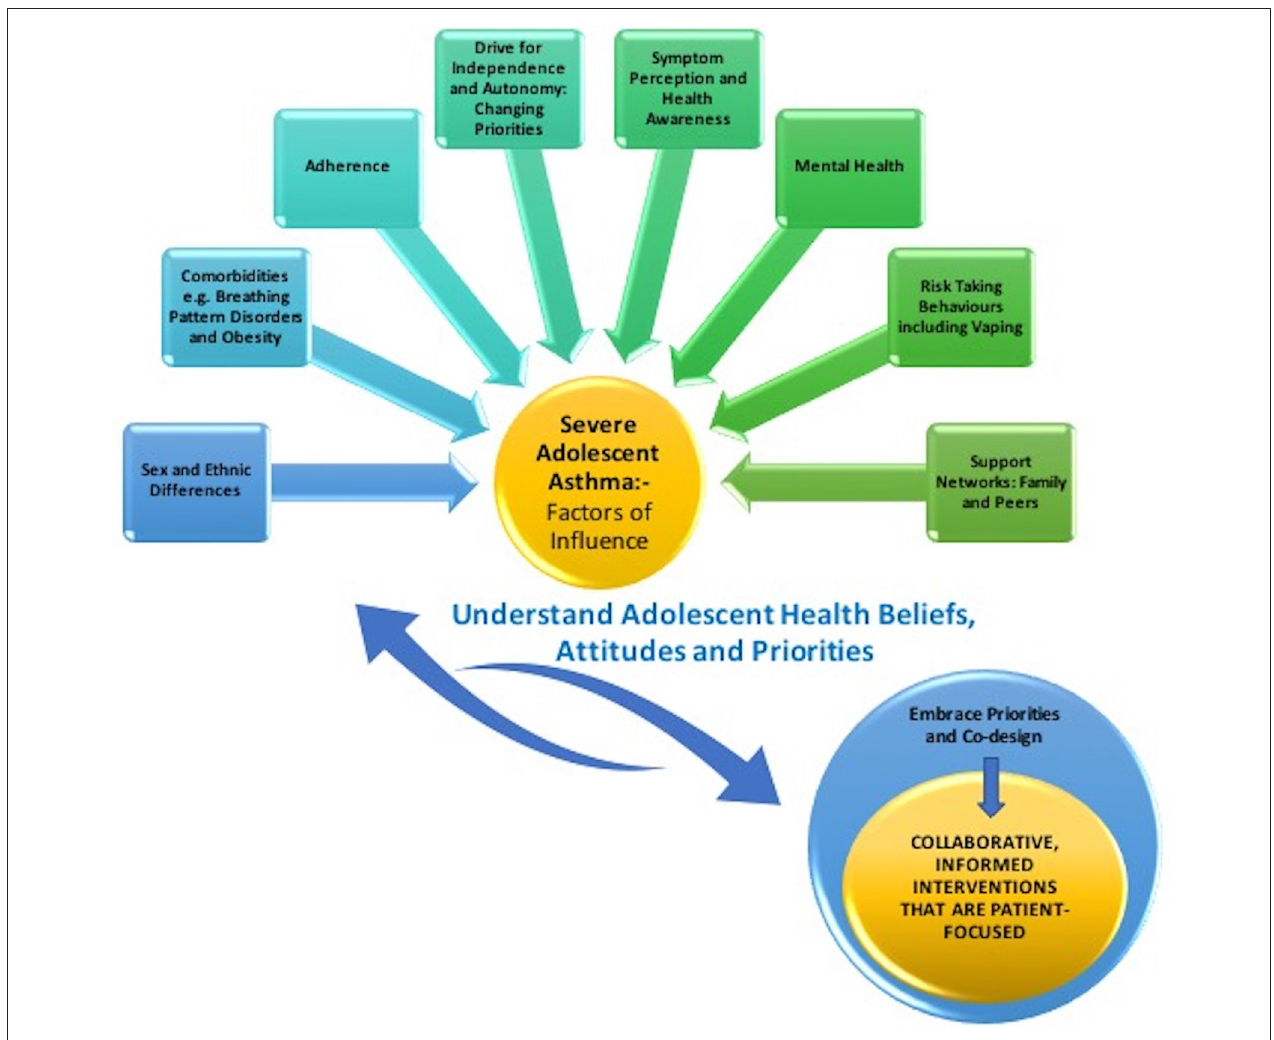
FIGURE 1 | Illustration of the interplay between factors of influence for the adolescent patient with severe asthma and collaborative working.